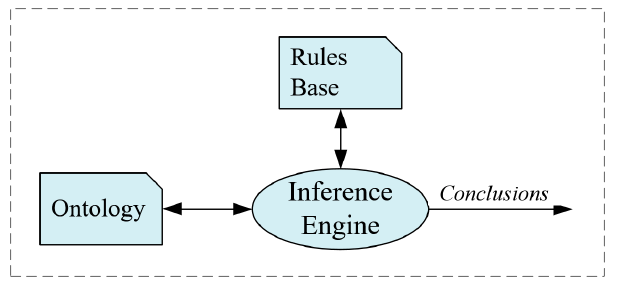
Figure 7. The structure of JESS.